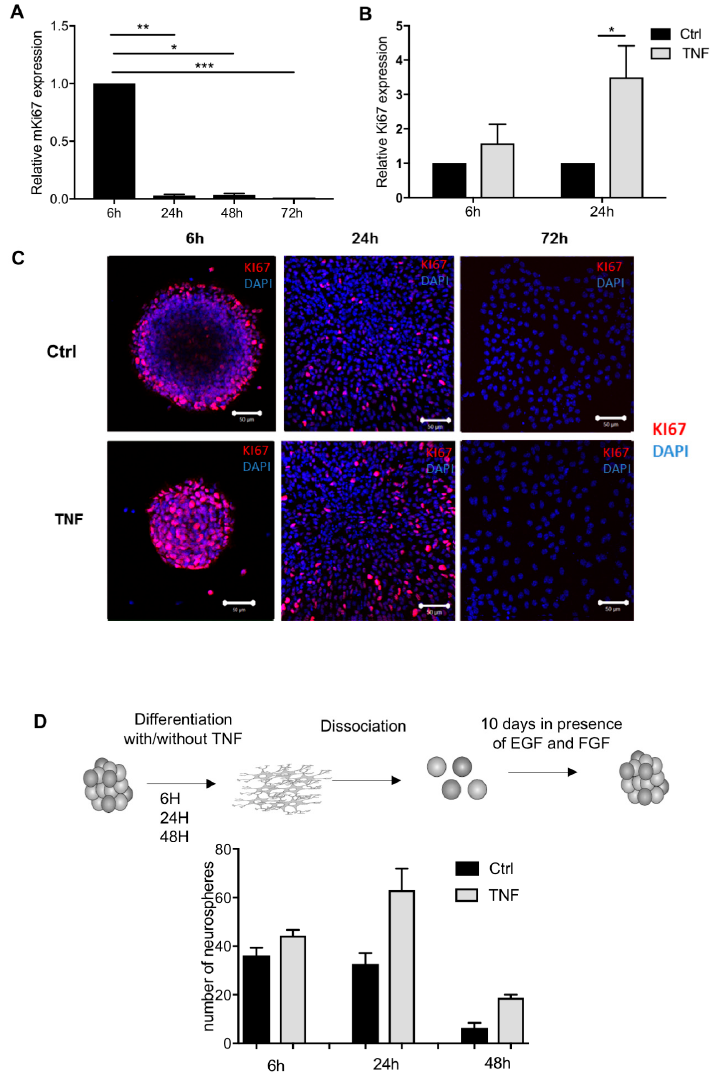
Figure 5. TNF increases neural progenitor cell proliferation. ( A ) Kinetic of mKi67 mRNA gene expres- sion obtained by RT-PCR. Each time point is normalized to its 6 h of differentiation (Ctrl = 1). Results are given as mean ± SEM ( n = 3) * p < 0.05, ** p < 0.01 and *** p < 0.001. ( B ) Effect of TNF treatment on mKi67 gene expression obtained by RT-PCR. Each time point is normalized to its FBS control (Ctrl = 1) * p < 0.05. Results are given as mean ± SEM ( n = 4). ( C ) Immunocytochemistry showing KI67 protein expression (red) in TNF treated cells at 6, 24, and 72 h. Nuclei were counterstained by DAPI (blue). Scale bar: 50 µ m. ( D ) TNF α induces the NSP reformation. After 6, 24, and 48 h of NSP-derived astrocyte differentiation treated with TNF α (50 ng/mL), an NSP reformation assay was performed in presence of EGF and FGF (20 ng/mL both, 10,000 cells/well). Ten days after, the number of reformed NSP at 6, 24, and 48 h was counted ( n = 3, mean ±